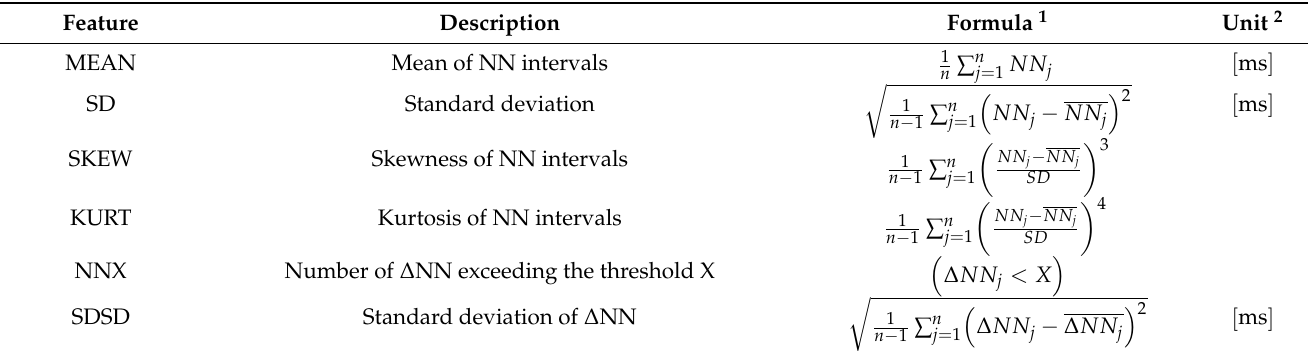
Table 1. HRV Statistical